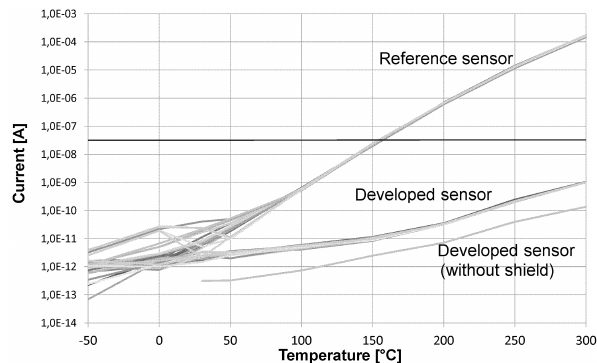
Figure 8. Temperature coefficient of the bridge resistance.